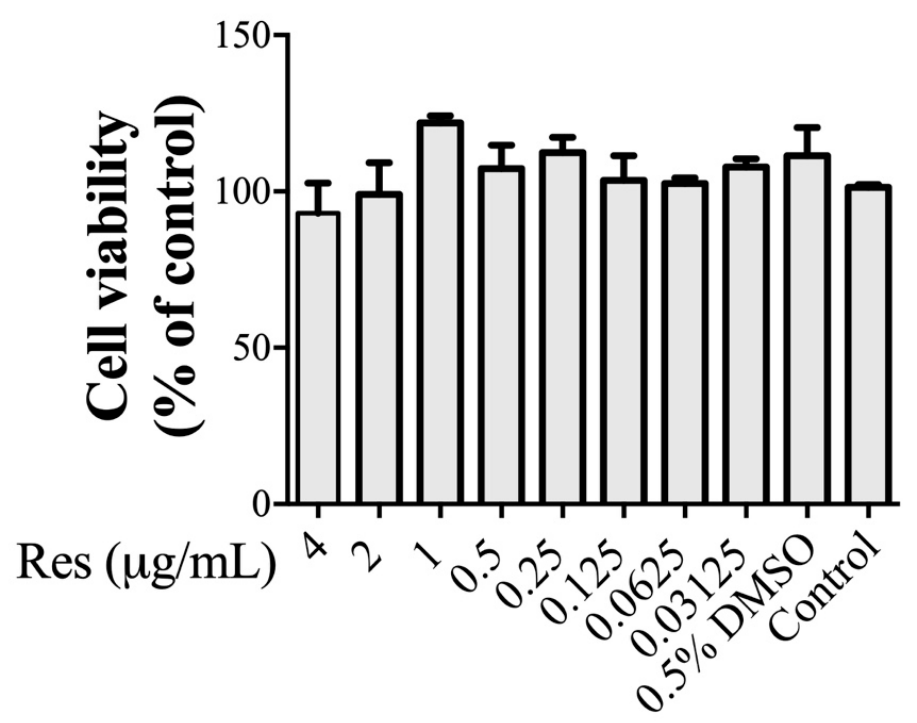
Figure 2. Effect of resveratrol on cell viability in ARPE-19 cells. Cells were treated with resveratrol at 4, 2, 1, 0.5, 0.25, 0.125, 0.0625, 0.03125 µ g/mL for 24 h. At the end of the respective treatments, MTS assays were performed as described in the materials and methods. The ratios are expressed as the percentage of viable cells normalized to the untreated control. The values of the MTS assay are mean ± SE of six replicates in each treatment.